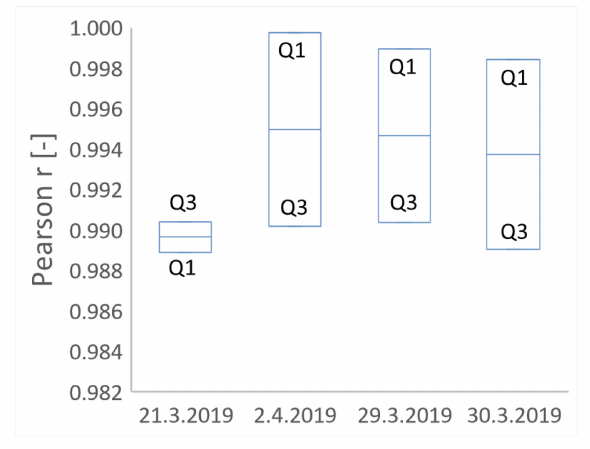
(cid:17) (cid:16) (cid:104) t (cid:105) outlet collector temperature T e h , i